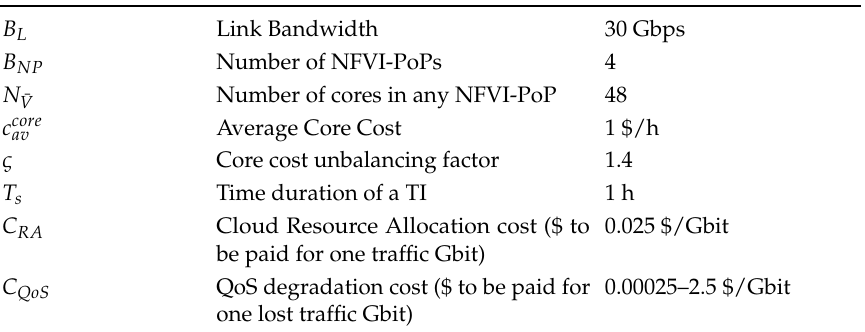
Figure 4. Deutsche Telekom network topology. The distances are expressed in km. Table 4. Input